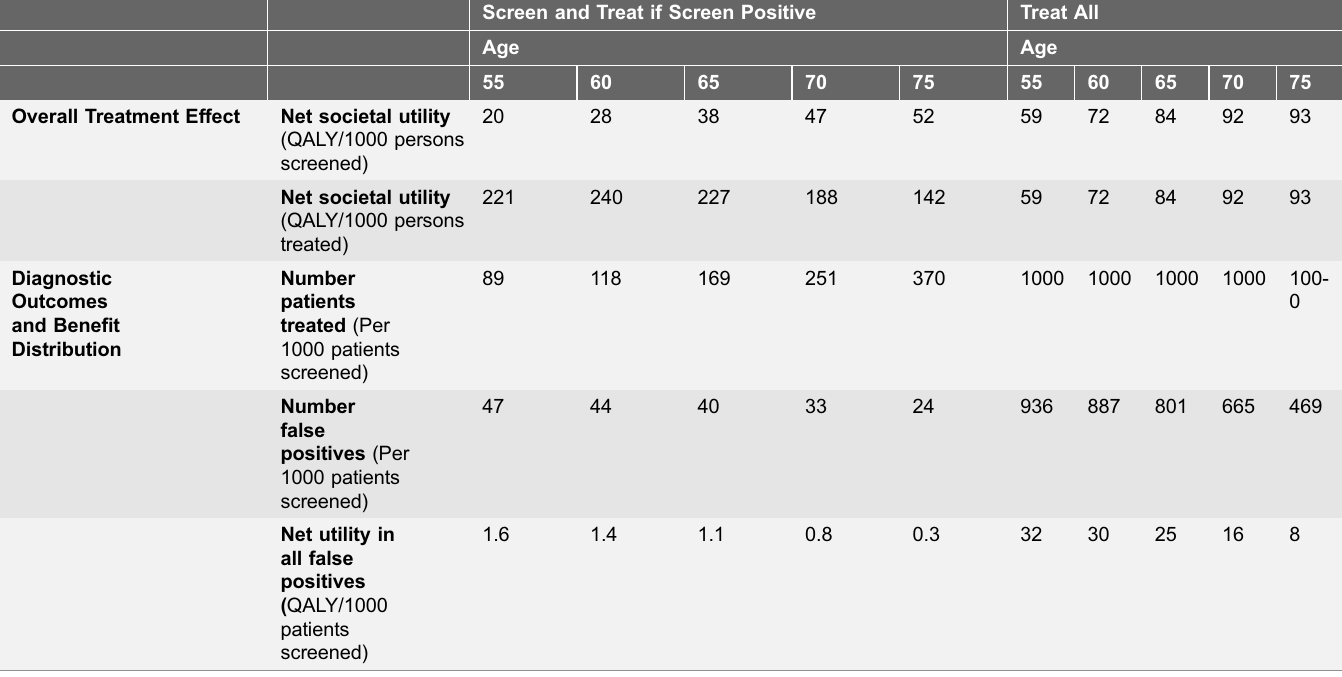
Table 2. Outcomes of base-case scenario for different age groups.